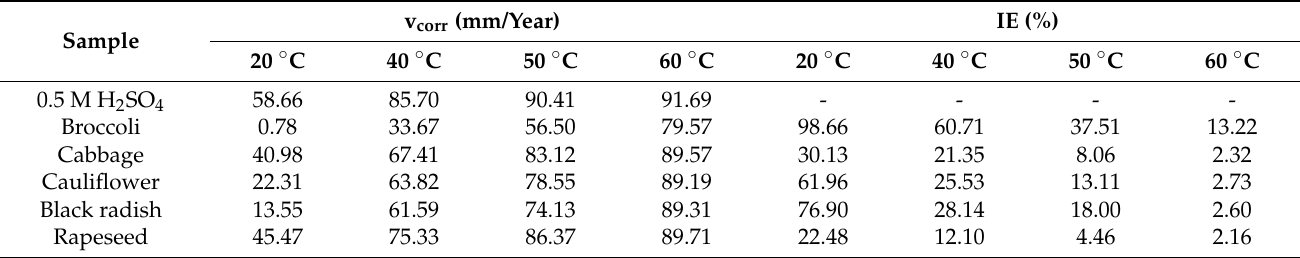
Table 4. Weight loss results of steel in 0.5 M H 2 SO 4 , at different temperatures, in the absence and presence of Brassicaceae extracts A.